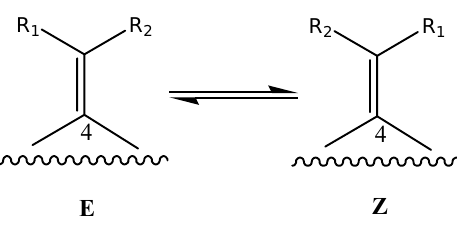
Figure 3. Two geometrical isomers of compounds 1 and 2 .